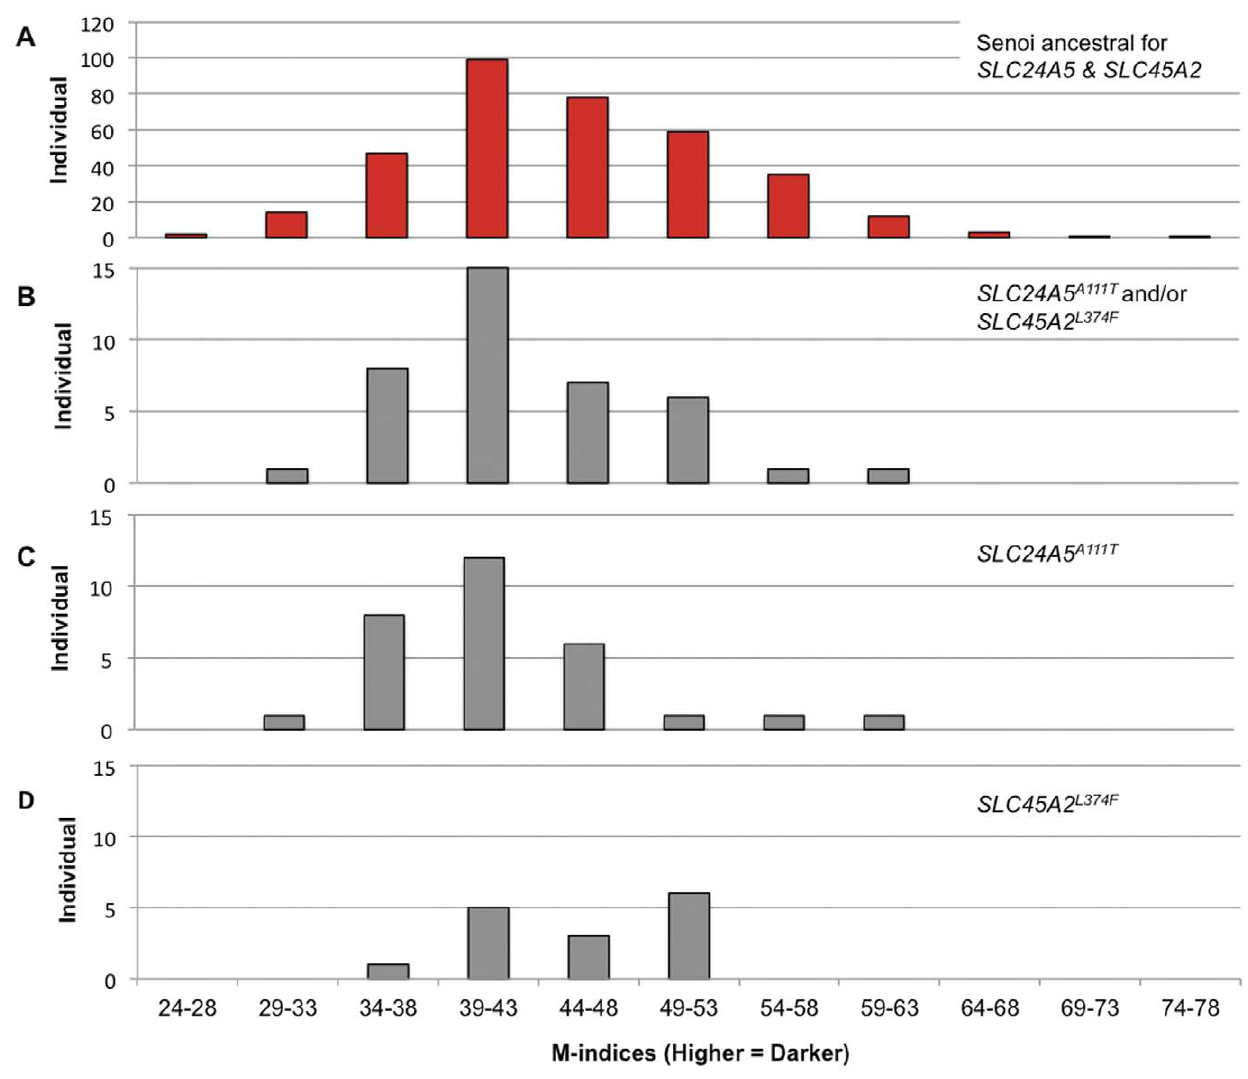
Figure 3. Distribution of M-indices of Senoi with and without derived alleles for SLC24A5andSLC45A2. (A) Senoi samples with SLC24A5 and SLC45A2 ancestral alleles. (B) Senoi with derived alleles for either SLC24A5 or SLC45A2 , or a combination of both. (C) Senoi with the derived allele of SLC24A5 . (D) Senoi with the derived allele of SLC45A2 .